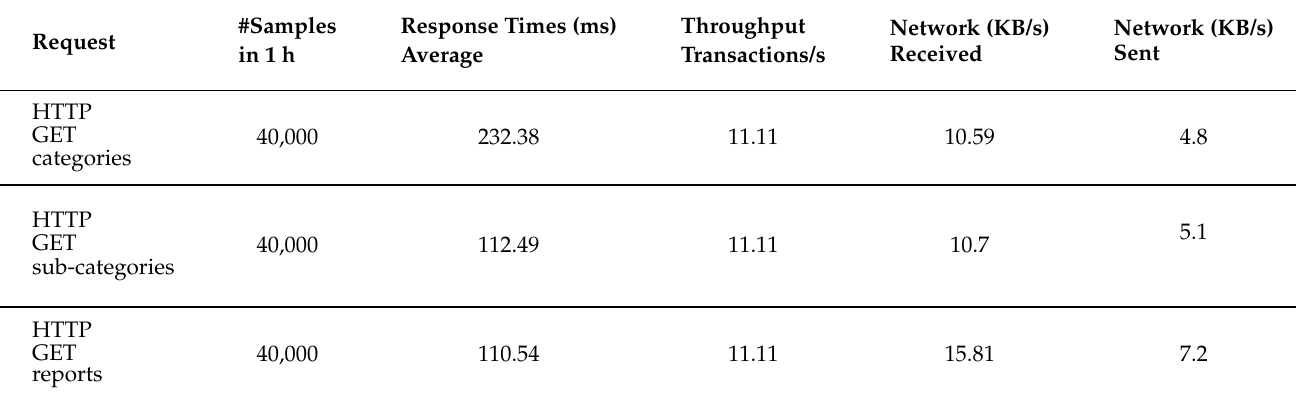
Table 6. Performance evaluation for submitting a report.